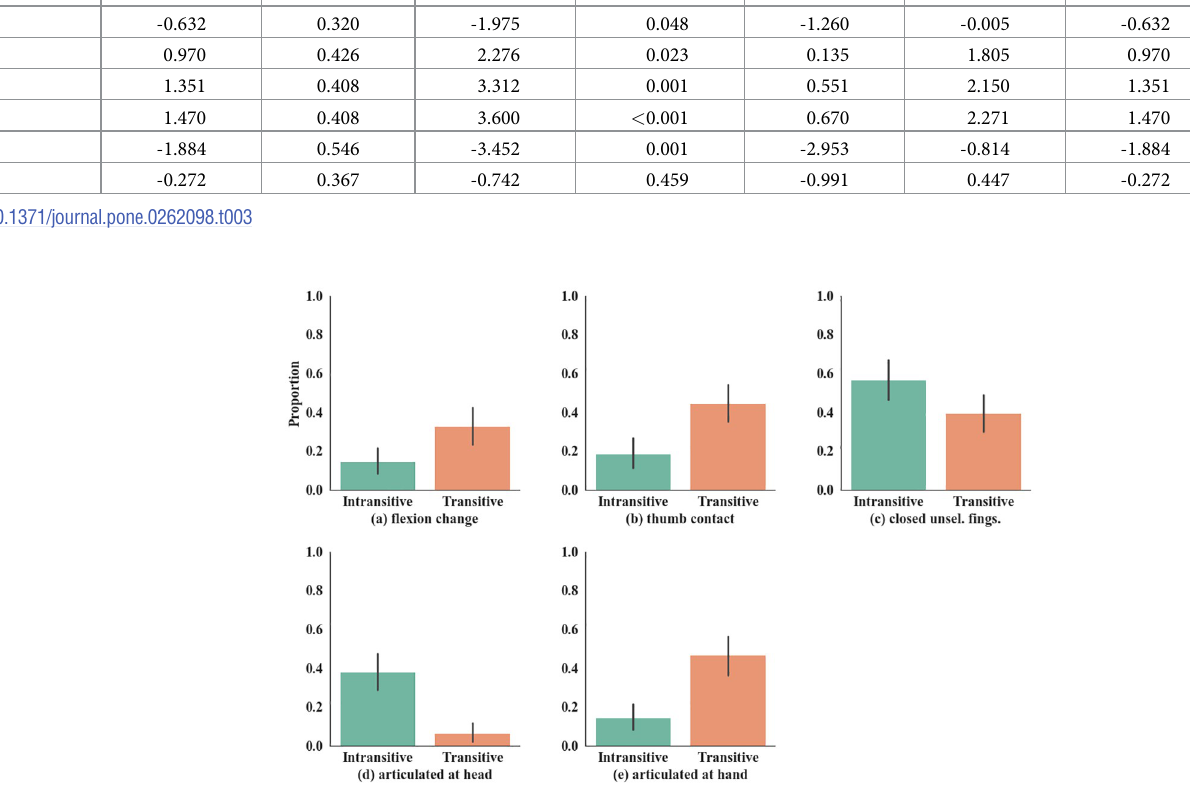
Fig 2. Handshape features. Handshape features (top row): Perceived transitive verbs are characterized by a change in flexion (a) and thumb contact (b). The closure of the unselected fingers was seen to be indicative of intransitive verbs, though not significantly (c). Location features (bottom row): Signs are also more likely to be perceived as transitive if articulated at the non-dominant hand (d). By contrast, verbs articulated at the head were more likely seen as intransitive